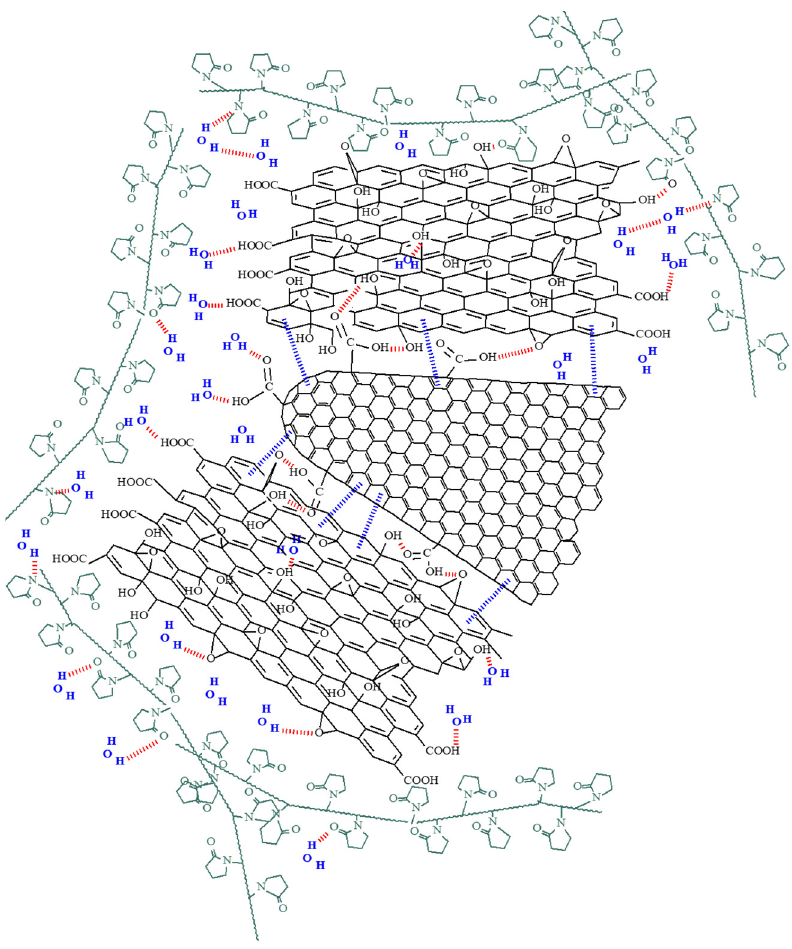
Figure 14. Possible structure for supramolecular aggregate generated by CNHox and GO through hydrogen bonds and pi-pi stacking interaction. Interaction of water molecules with these supermolecules is the core of the humidity sensing.